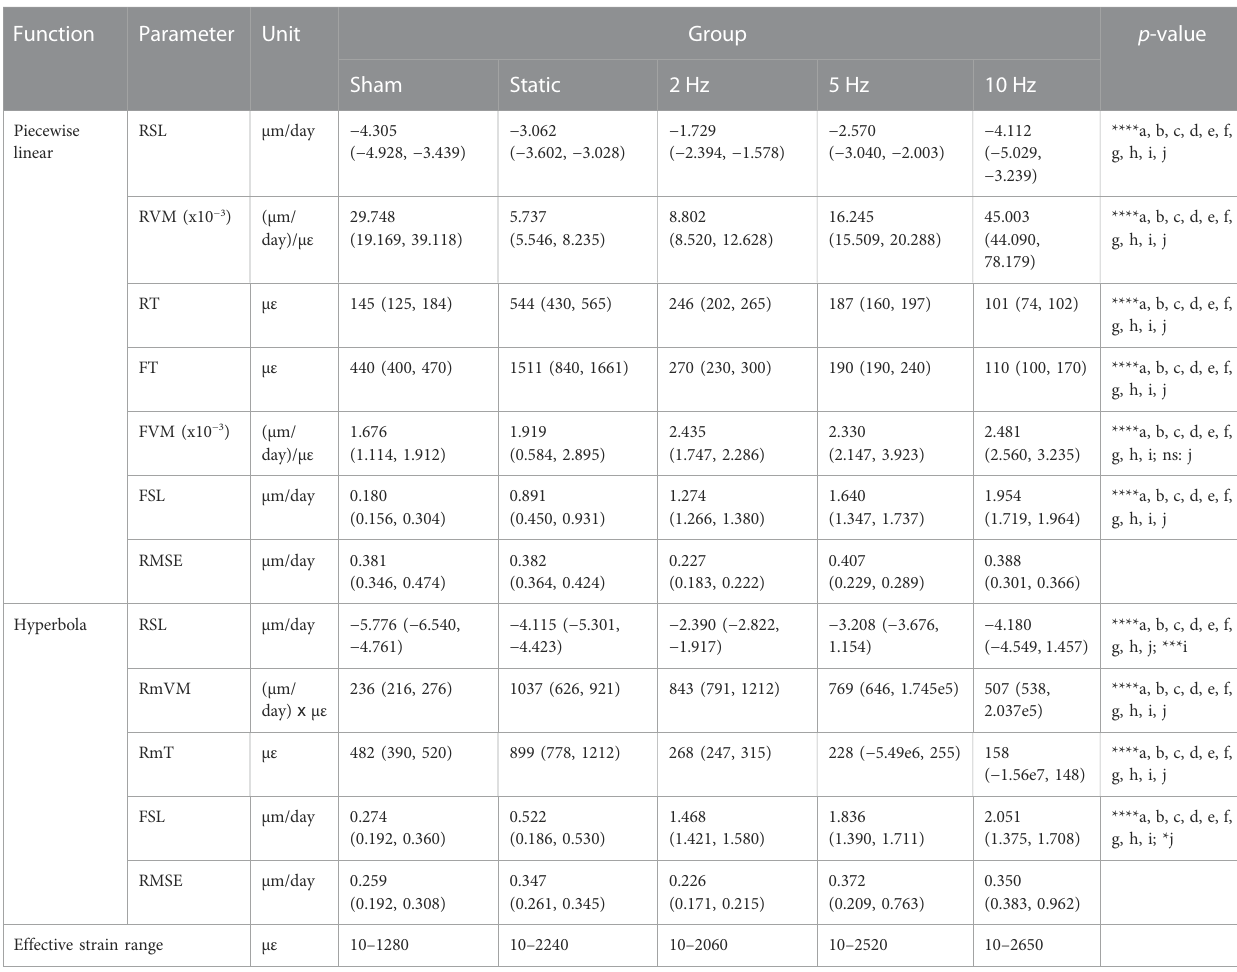
TABLE 3 Parameters of the mathematical functions fi tted to the estimated mechanostat group average (re)modeling velocity curves for the interval weeks 0 – 4. Data presented as “ parameter (IQR), ” where the IQR was estimated using the balanced bootstrapping approach described in the methods (see section “ Mechanostat (re)modeling velocity curve and parameter derivation ” ) to provide an estimate for the variability of each parameter. Root mean squared error (RMSE) was used to characterize the quality of the fi t. The row “ Effective strain range ” indicates the range of mechanical signal values from which the fi t of the mathematical functions was derived. Mechanical signal values obtained from micro-FE analysis using homogeneous material properties. Parameter legend (see Materials andMethodsandTable1foranextendeddescription):Resorptionsaturationlevel (RSL),Resorptionvelocity modulus(RVM),Resorptionthreshold (RT), Formation threshold (FT), Formation velocity modulus (FVM), Formation saturation level (FSL), (Re)modeling threshold (RmT), (Re)modeling velocity modulus